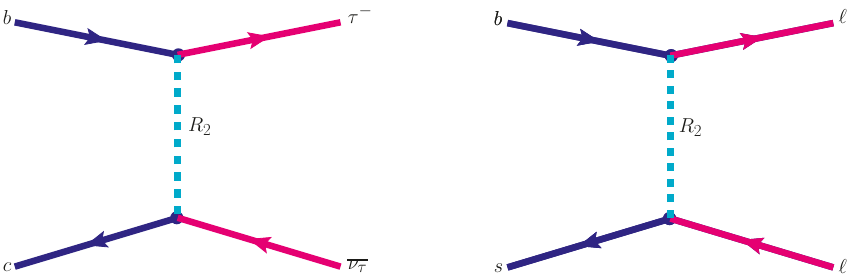
Figure 4 . Feynman diagram for the CC transition b → cτ − ¯ ν τ (left panel) and NC process b → s‘ + ‘ − (right panel) induced by the scalar leptoquark R (2 / 3) 2